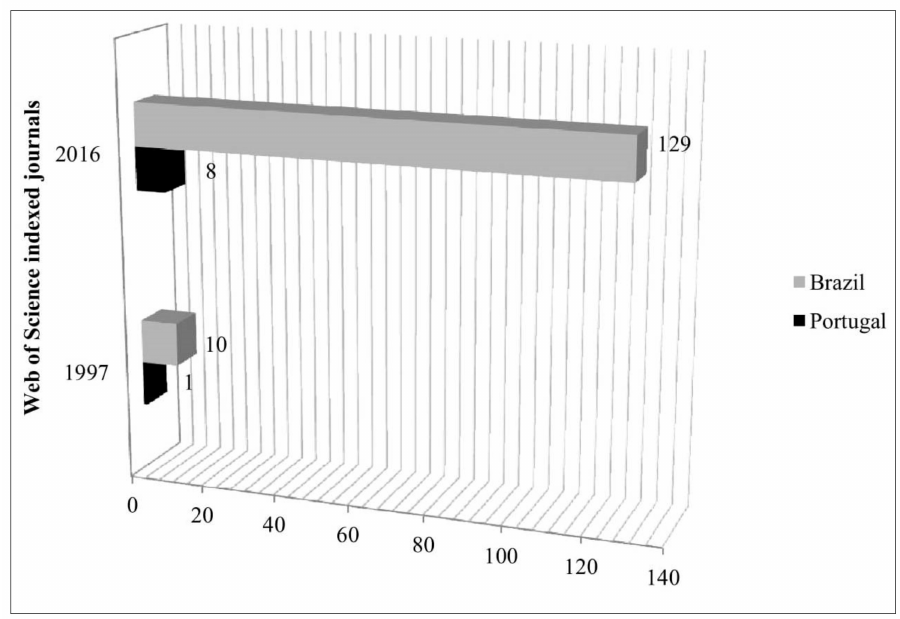
Figure 3. Portuguese- and Brazilian-based indexed journals (1997 vs.